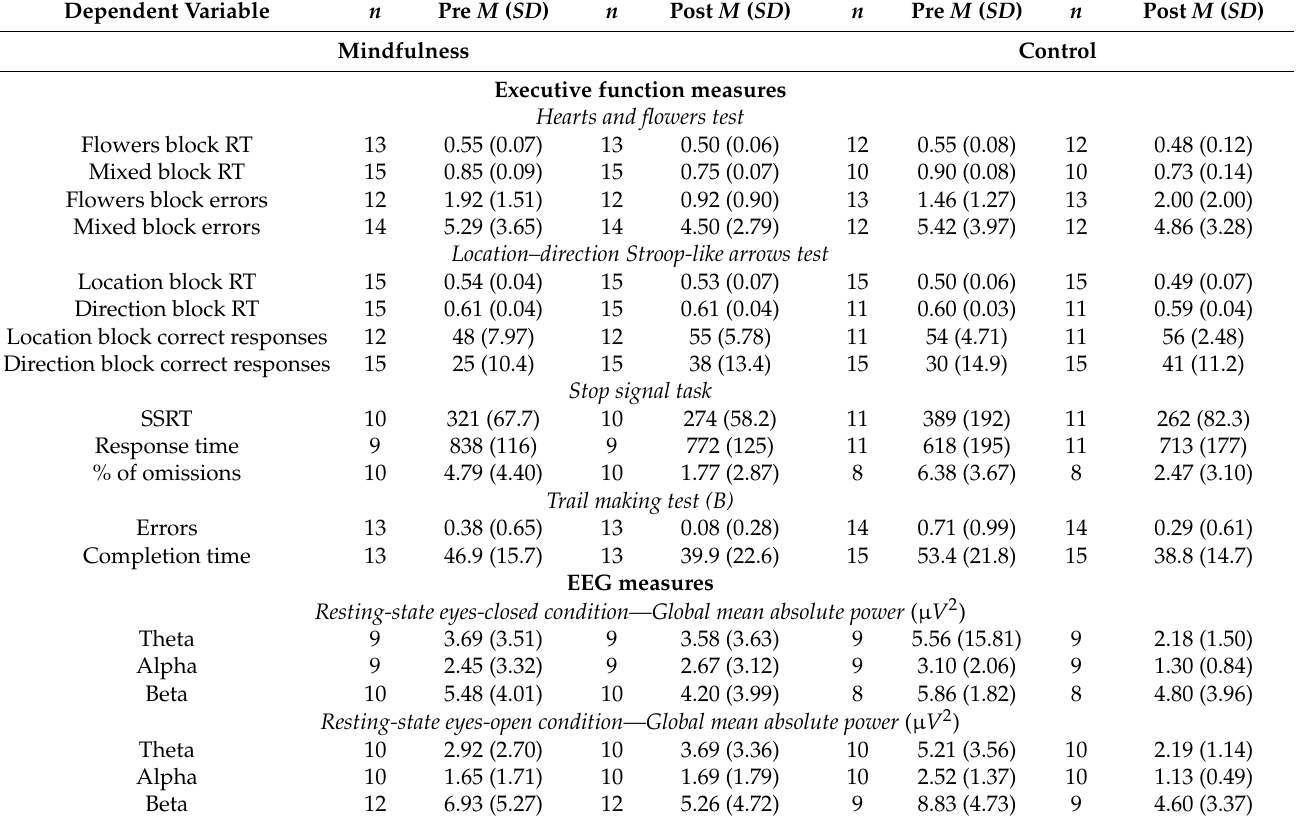
Table 1. Means and standard deviations of all dependent variables included in the